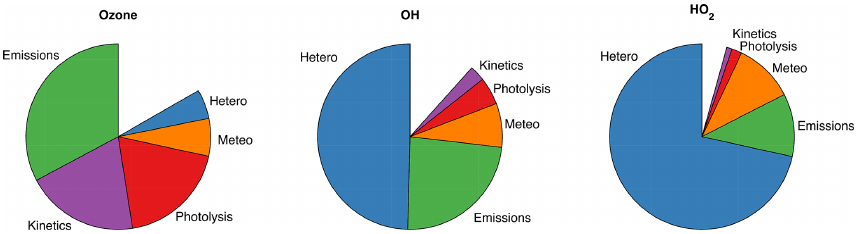
Figure 4. First-order sensitivity indices for modeled O 3 , OH, and HO 2 during ARCTAS-A averaged across all flights and binned by cate- gories defined in Table 1.